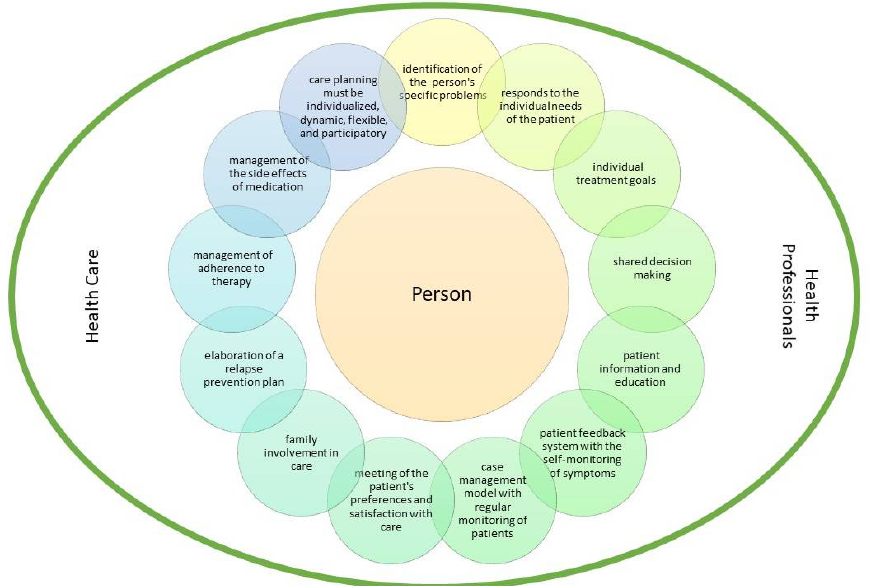
Figure 2. Patient-centered care model.